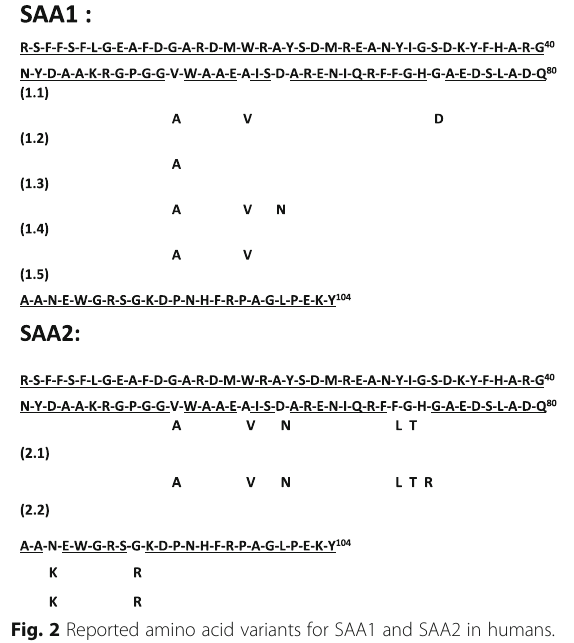
Fig. 2 Reported amino acid variants for SAA1 and SAA2 in humans. Underlined regions appear